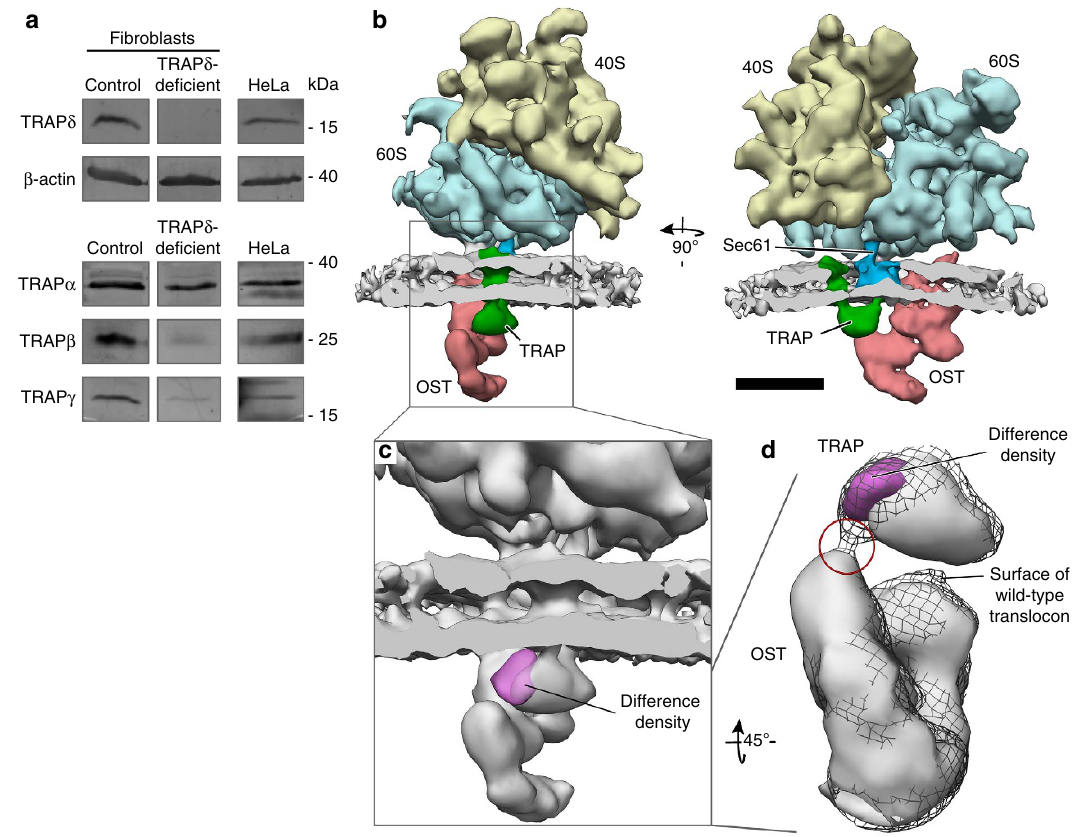
Figure 2 | TRAP d is located at the TRAP-OST interface. ( a ) Western blot analysis of control and TRAP d -deficient patient primary fibroblasts. HeLa cells were used as positive control for the TRAP antibodies. Please note that bands for HeLa cells and control fibroblasts are duplicated with Fig. 3a because samples were run on the same gel. ( b ) Subtomogram average of the ER-associated ribosome from TRAP d -deficient primary fibroblasts, including the large (blue) and small (yellow) ribosomal subunits, the membrane bilayer (grey), the Sec61 protein-conducting channel (dark blue), OST (red) and TRAP (green). A total of 2319 subtomograms were averaged. Scale bar, 10nm. ( c ) Zoomed view of the area indicated in b . The difference density map (magenta) between the TRAP d -deficient and wild-type mammalian translocons is superimposed on the subtomogram average (grey). ( d ) Structure of the wild-type mammalian translocon (black mesh) superposed with the elements shown in c . TRAP and OSTare shown from the perspective of the ER lumen, with the membrane removed. The contact site between TRAP and OST in the wild-type mammalian translocon is indicated (red